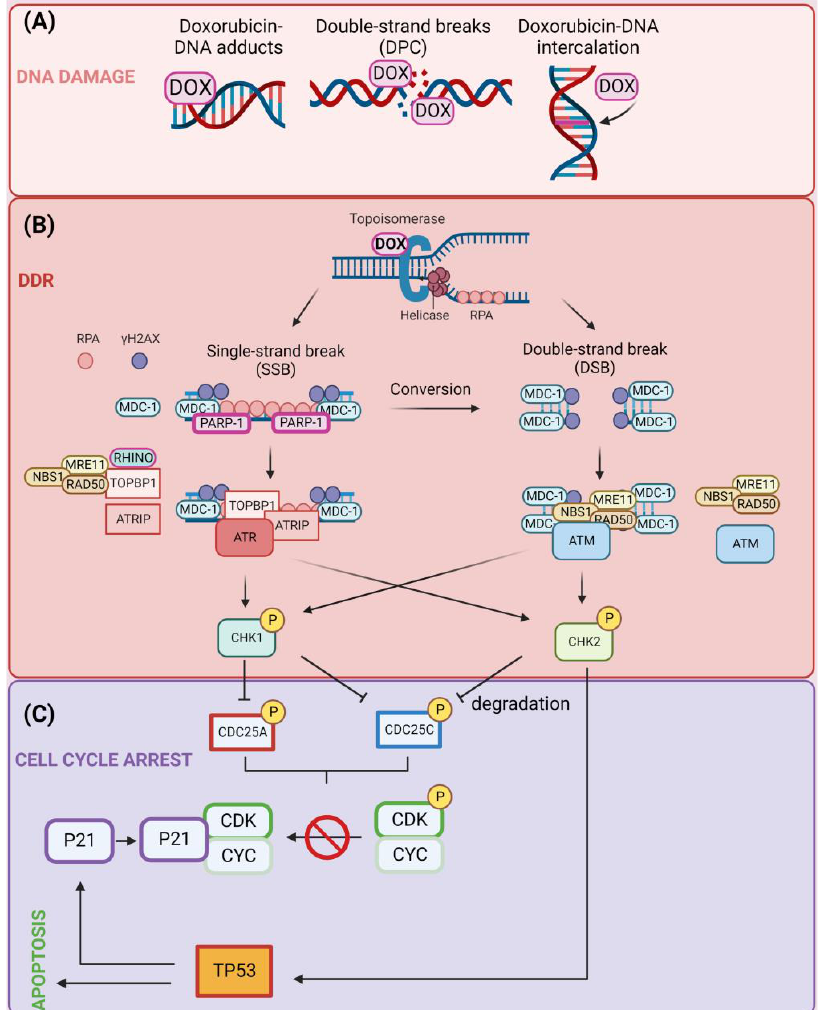
Figure 1. ( A ) Induction of DNA damage following treatment of cells with doxorubicin (DOX). DOX induces DNA damage through three main mechanisms: the formation of DNA adducts, single-strand break (SSB) induction, and double-strand break (DSB) induction, in which DNA strands remain bound to trapped topoisomerase enzymes through DNA–protein crosslinks (DPCs) and intercalation of DOX in the DNA molecule. ( B ) Activation of DNA damage response (DDR) pathway. Trapping of topoisomerase enzymes by DOX induces the formation of either SSBs or DSBs. SSBs are detected by poly [ADP-ribose] polymerase 1 (PARP-1), and the ssDNA is covered with replication protein A (RPA). This results in the recruitment of a variety of factors including DNA topoisomerase 2-binding protein 1 (TOPBP-1), RAD9, RAD1, HUS1 interacting nuclear orphan (RHINO), ATR-interacting protein (ATRIP), MRE11–RAD50–NBS1 complexes, and serine/threonine-protein kinase ATR that contribute to the formation of γH2AX protein foci at the sites of damage. DSBs are detected by MRN complexes, which recruit a mediator of DNA damage checkpoint protein 1 (MDC-1) and amplification of the foci formation by ataxia telangiectasia mutated (A-T mutated) (ATM) kinase. Consequently, ATR and ATM kinases phosphorylate checkpoint kinases CHK1 and CHK2. ( C ) Induction of apoptosis or cell-cycle arrest by DOX. The CHK1/2-mediated phosphorylation of CDC25A/C phosphatases leads to their degradation and as a consequence no dephosphorylation of CDK-cyclin complexes that prevent cell-cycle progression. Alternatively, CHK2 phosphorylates and activates cellular tumor antigen p53 (TP53) transcription factor leading to up-regulation of P21, which binds unphosphorylated (active) CDK–cyclin complexes and contributes to cell-cycle arrest. Created with BioRender.com accessed on 1 January 2023.